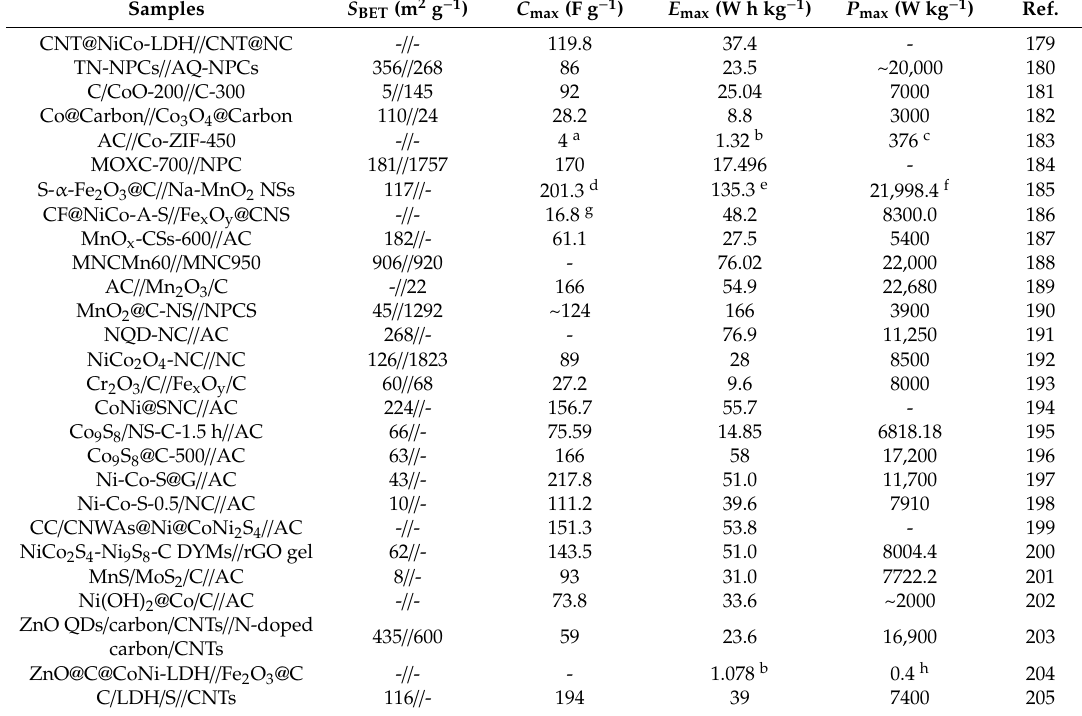
Table 11. Electrochemical performances of the asymmetric supercapacitors (ASCs) based on carbon